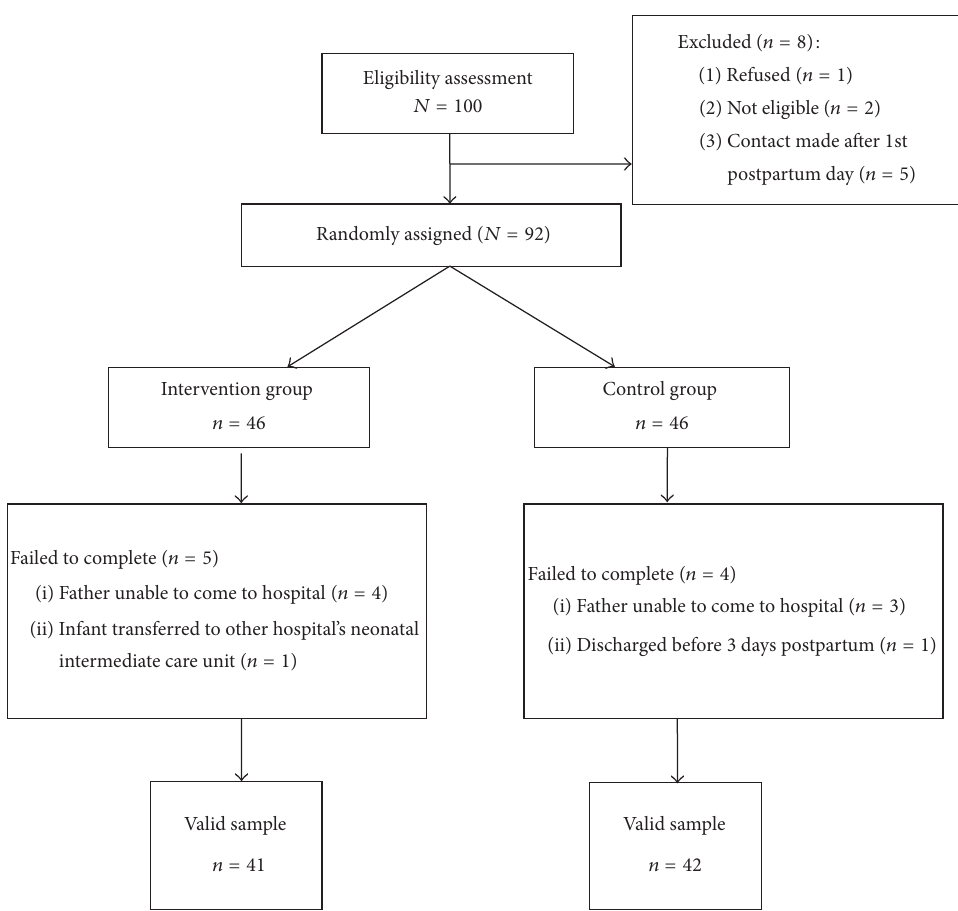
Figure 1: CONSORT diagram. Passage of participants through each trial stage.